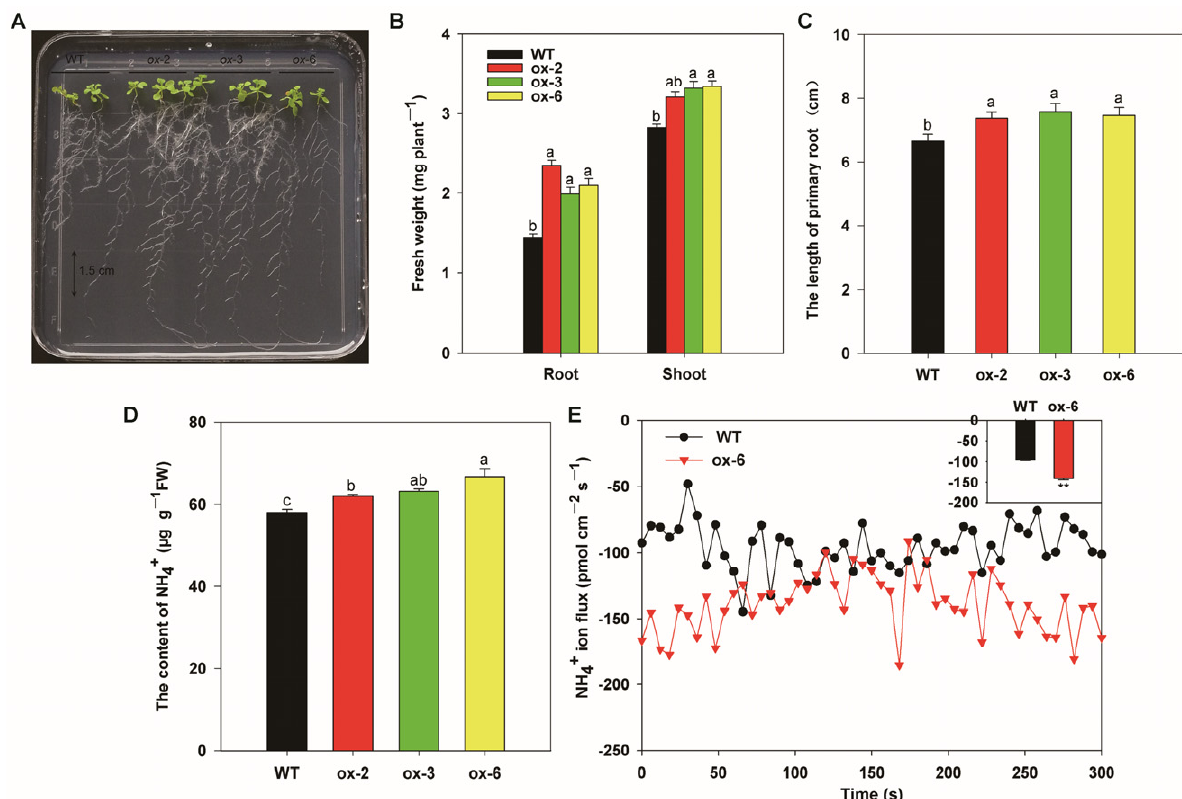
Figure 9. Overexpression of BcAMT1;5 in Arabidopsis improves plant growth at 0.25 mmol L − 1 NH 4+ as an N source. ( A ) The growth phenotype of wild-type and the fourth-generation transgenic lines. Seedlings were precultured vertically on solid medium at 4 mmol L − 1 NO 3 − and were transferred to 0.25 mmol L − 1 NH 4+ for 10 d. ( B ) Fresh weight of the wild-type and the lines of overexpressing vector and BcAMT1;5 . ( C ) The length of the primary root of wild-type and the lines of overexpressing BcAMT1;5 . ( D ) NH 4+ content of whole plants of wild-type and the lines of overexpressing BcAMT1;5 . ( E ) NH 4+ ion flux of wild-type and the line 6 of overexpressing BcAMT1;5 . WT: wild-type, ox-2, ox-3, and ox-6 present the line 2, 3, and 6 of overexpressing BcAMT1;5 , respectively. Line chart: time series plot of NH 4+ fluxes; histogram: diagram of NH 4+ fluxes. Data represent mean ± SE ( n = 10 in ( A – C ); n = 3 in ( D ); n = 6 in ( E )), different letters above the bars indicate significant differences at p < 0.05, and ** in the histogram shows significant differences at p < 0.01.